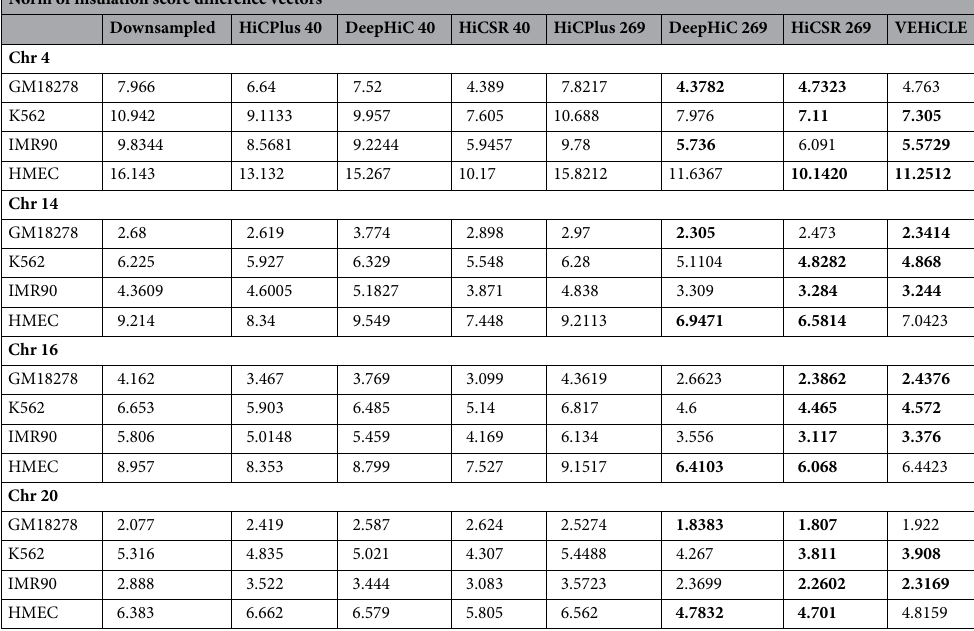
Table 3. L2 norm of TAD Insulation difference vectors against target insulation vectors. Networks are trained using the training set chromosomes of the GM12878 cell line and evaluated on the test chromosome sets of the K562, IMR90, HMEC and GM12878 cell line. The top 2 scores for each metric are